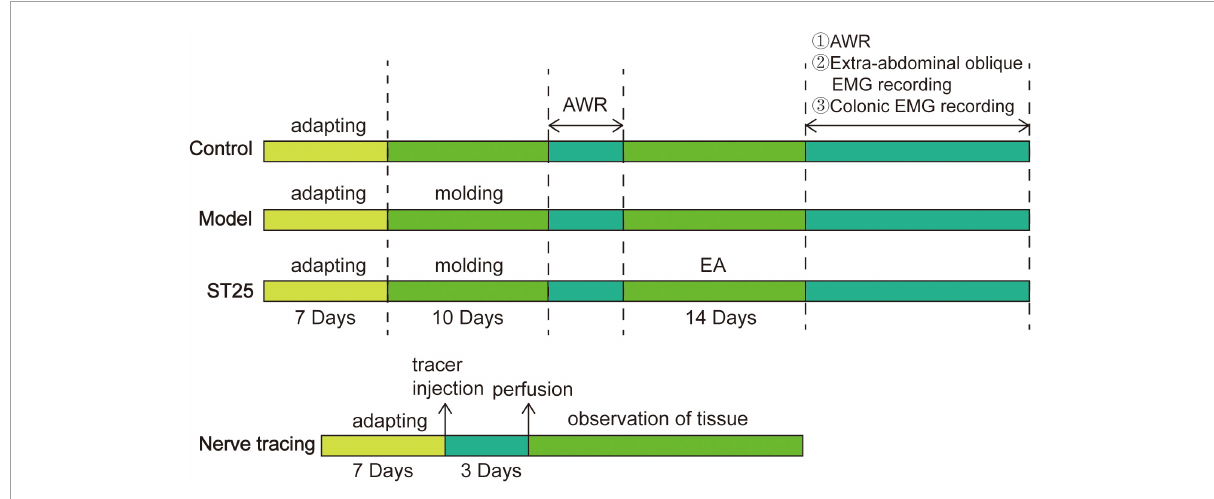
FIGURE1 A flowchart of experimental protocol: intervention timeline for the control group, model group, ST25 group, and nerve tracing group. AWR, Abdominal withdrawal reaction.